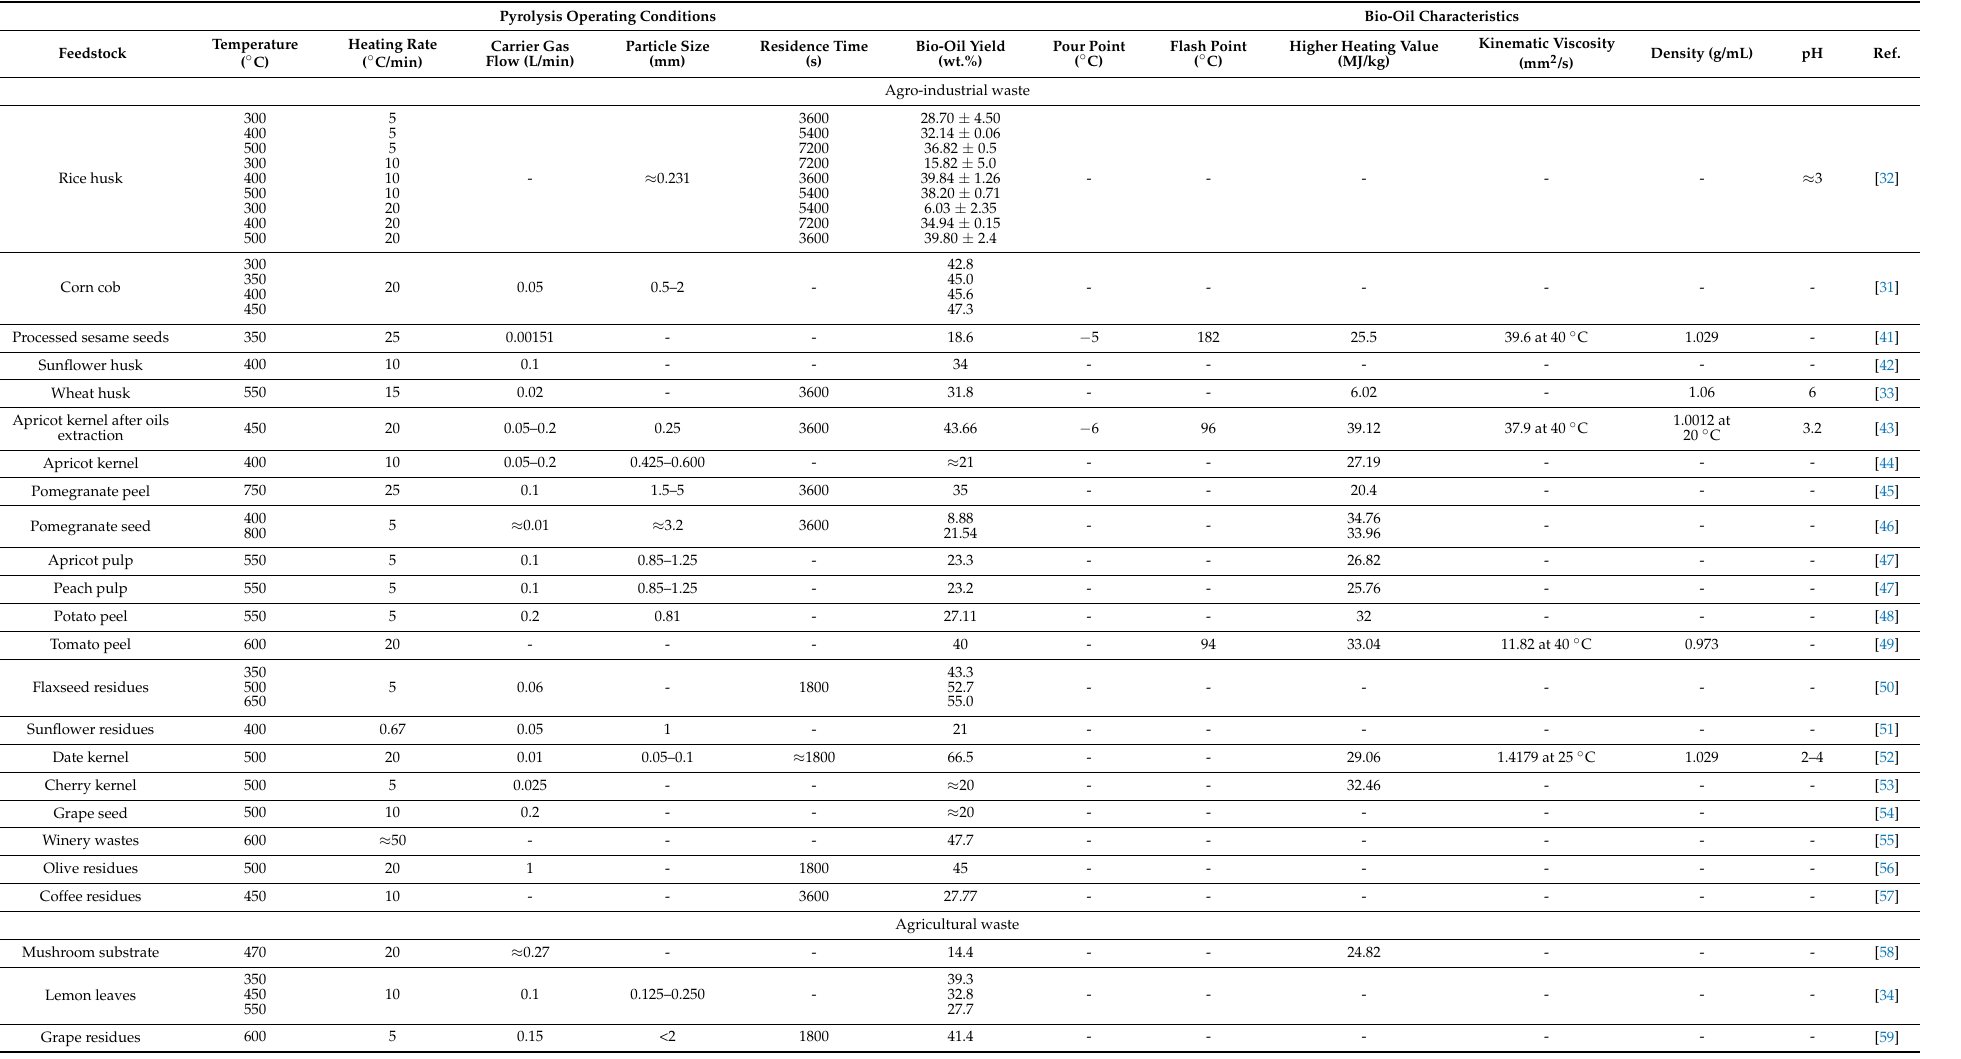
Table 6. Slow pyrolysis operating conditions of different feedstocks and characteristics of produced